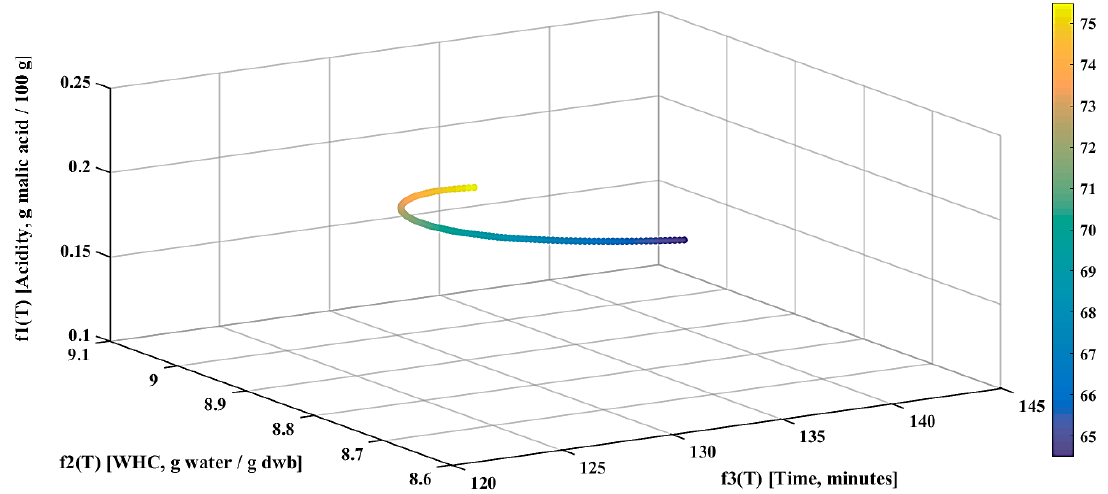
Figure 9. A four-dimensional plot of the Pareto-optimal front in the 64.5 to 75.5 °C interval.